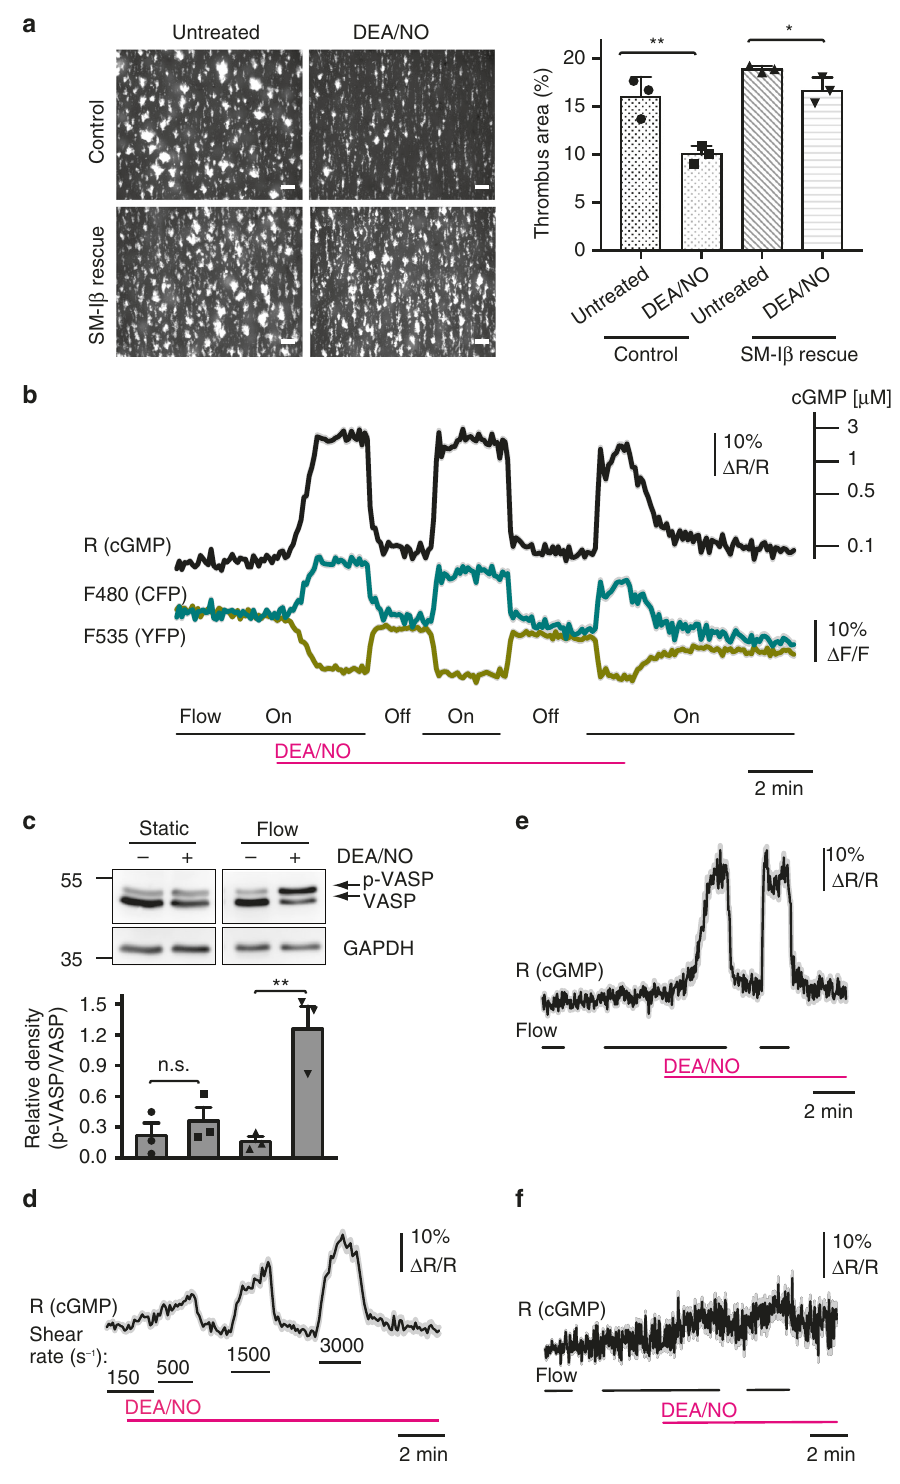
were artifacts was excluded by several control experiments. First, the individual emission intensities for CFP (cyan) and YFP (yellow) changed into opposite directions indicating that a proper FRET change was observed with our ratiometric sensor rather than quenching or fl uorescence artifacts (Fig. 1b). Second, the fl ow-dependent FRET/cGMP signals correlated well with phosphorylation of vasodilator-stimulated phosphoprotein (VASP) (Fig. 1c), a well-known substrate of cGMP-activated